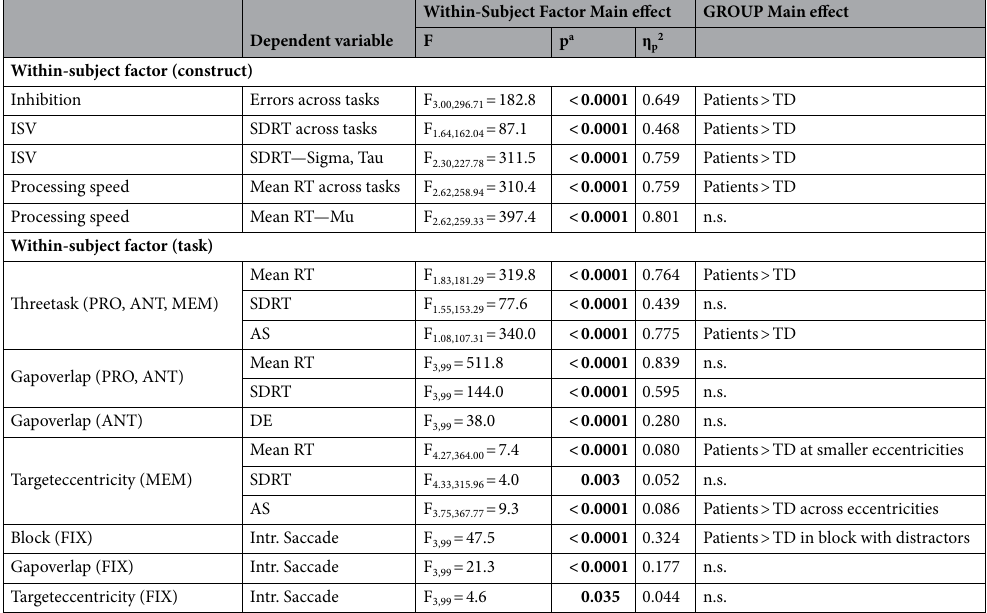
Table 3. Significant within-subject factors and group main effects. ISV Intra-subject variability , Mean RT Mean response time , SDRT Standard deviation of response time , Errors across tasks anticipatory saccade in PRO, anticipatory saccade and direction error in ANT, anticipatory saccade in MEM, intrusive saccade in FIX and commission error in GNG, SDRT across tasks SDRT across tasks standard deviation of response time across PRO, ANT, MEM and GNG, SDRT—Sigma, Tau standard deviation of response time from ANT and MEM and Sigma and Tau from PRO and GNG, Mean RT across tasks Mean response time across PRO, ANT, MEM and GNG, Mean RT—Mu Mean response time from ANT and MEM and Mu from PRO and GNG, AS anticipatory saccade , DE direction error from ANT, Intr. Saccade Intrusive Saccade from FIX,